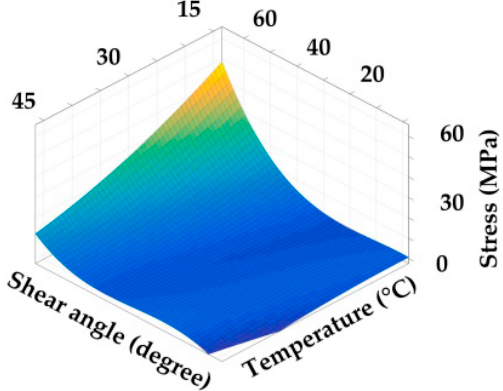
Figure 13. Stress–strain–temperature envelope surface of shear test.